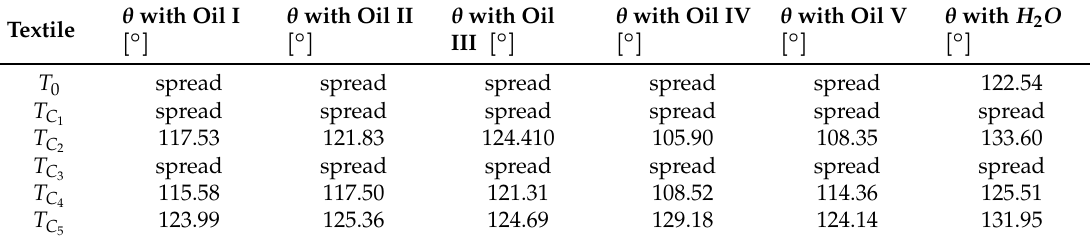
Figure 6. Calculated surface energies of textiles and their components. Table 7. ’sessile drop’ contact angles ( θ ) between textiles and functional fluids.